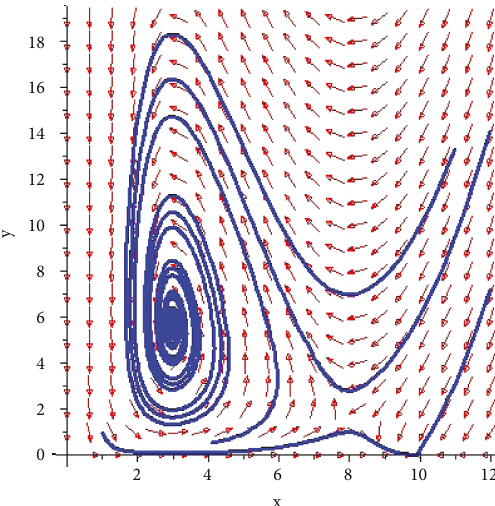
Figure 1: The vector diagram of system (8) where r = 4 , a = 0 4 , b = 0 5 , m 1 = 3 , and m 2 = 8 .